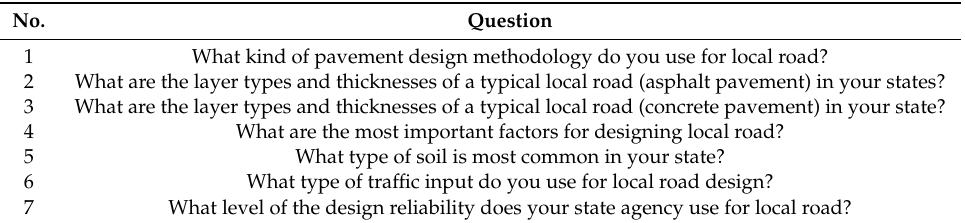
Table 1. Survey questions with respect to pavement design procedures for low-volume roads.